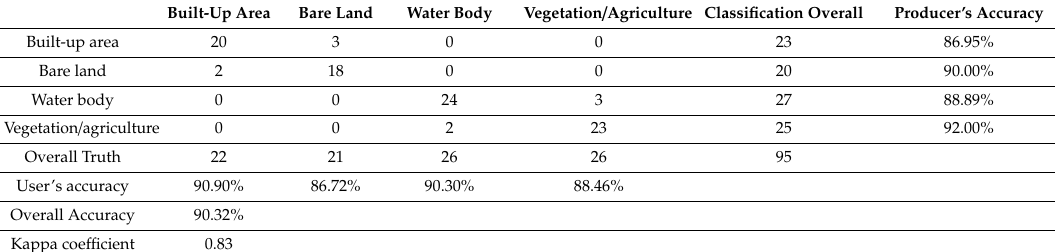
Table A1. Confusion matrix of the 2019 LULC map of